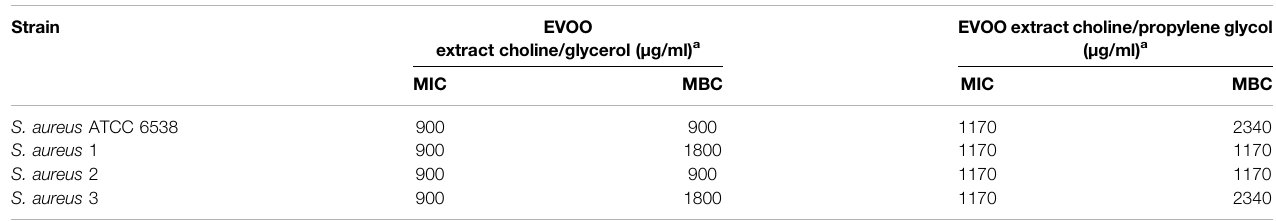
TABLE 3 | Antibacterial activity of EVOO extracts in NaDESs against Gram-positive standard strains and drug-resistant clinical isolates.